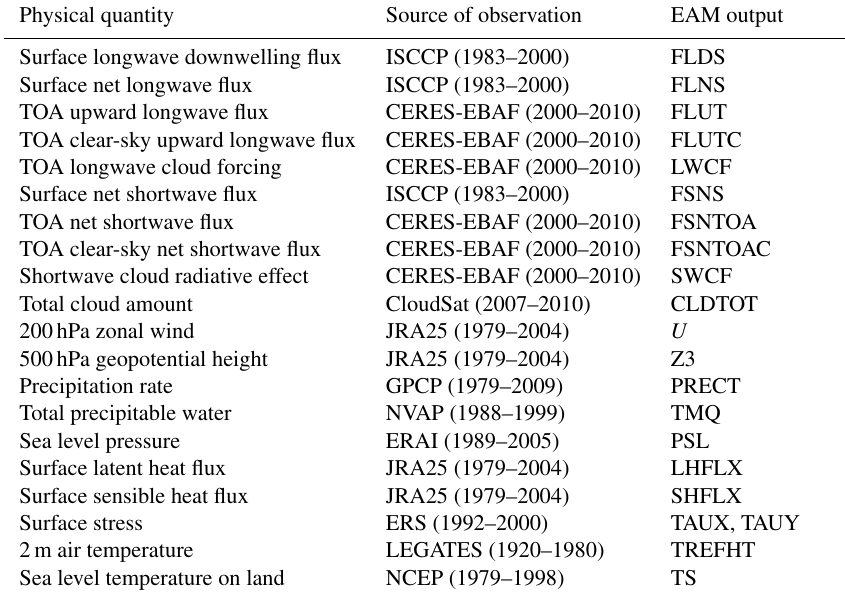
Table 2. List of observational data and EAM’s output variables used for evaluating model biases. The observational data were obtained from NCAR’s AMWG diagnostics package (http://www.cgd.ucar.edu/amp/amwg/diagnostics/plotType.html, last access: 6 April 2021). TOA stands for “top of